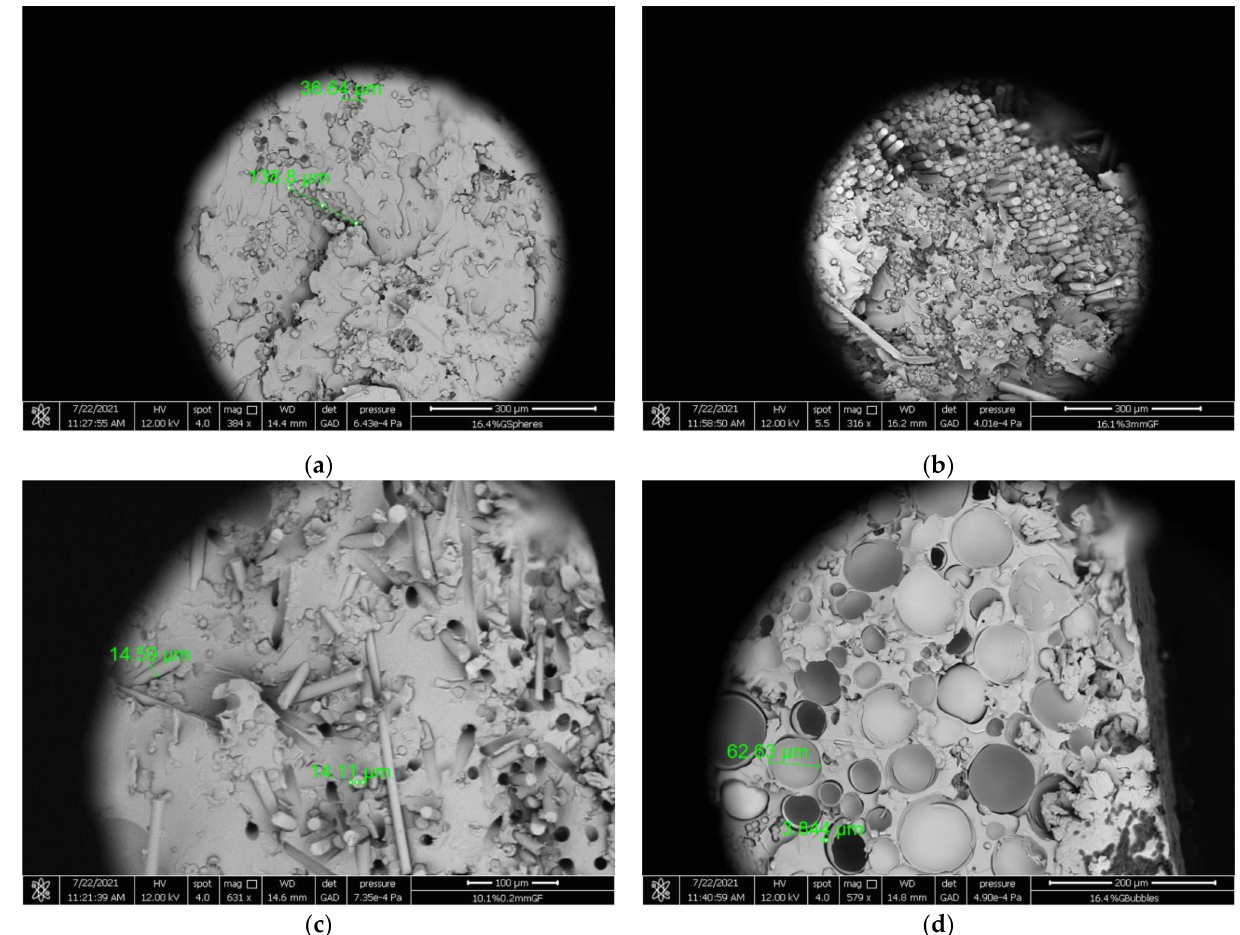
Figure 9. Scanning electron micrographs of the hybrid epoxy matrix composite specimens manufactured for ( a ) 26.4% V f glass spheres, ( b ) 31.6% V f 3 mm glass fibers, ( c ) 16.6% V f 0.2 mm glass fibers and ( d ) 32.5% V f glass